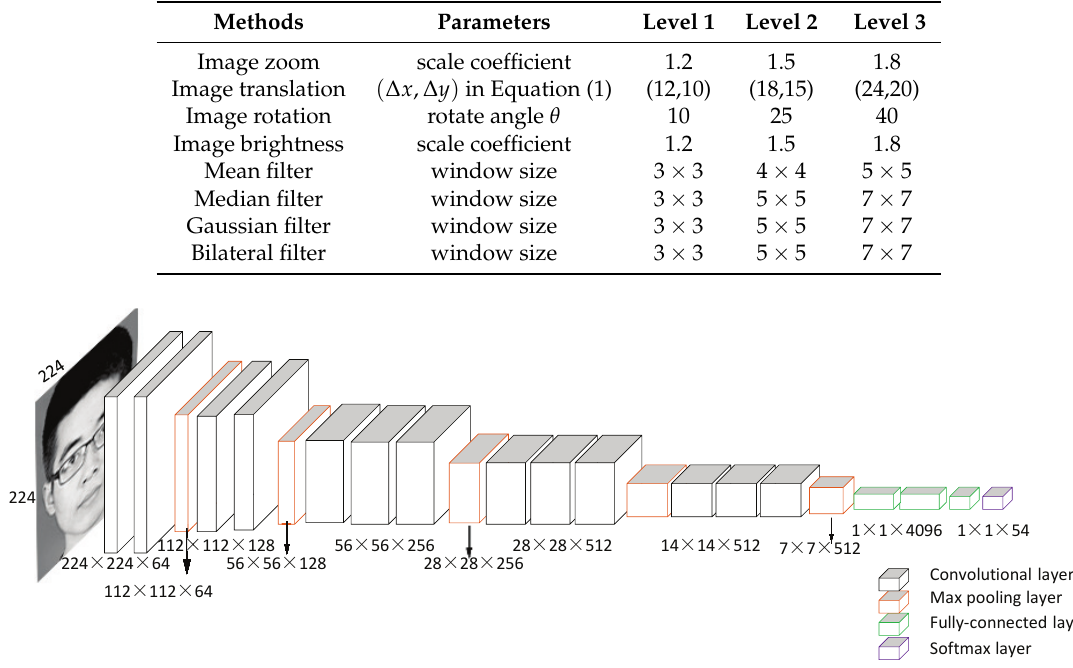
Figure 1. An illustration of the architecture of the VGG-16